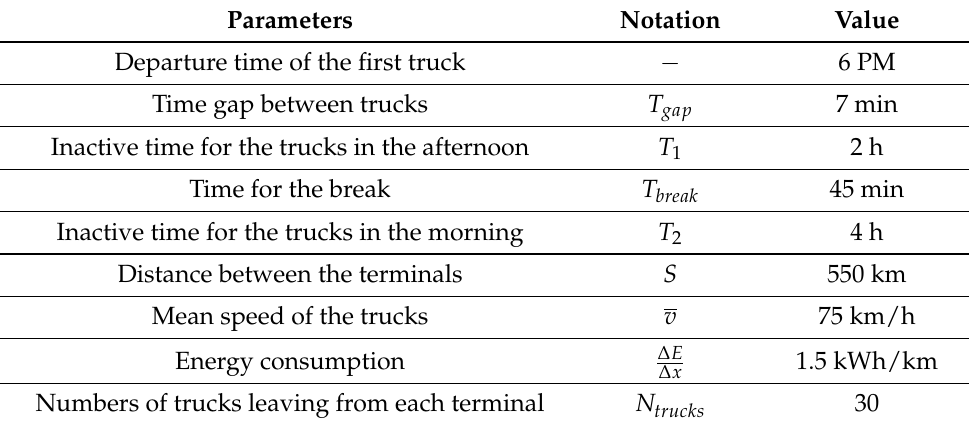
Figure 1. The assumed 550 km transport route is plotted on a map of Europe as a reference. Table 1. Notations for the different parameters and their values used in this